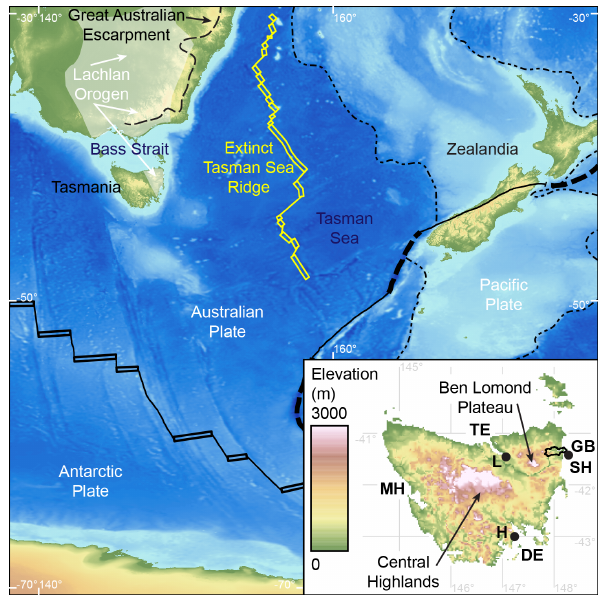
Figure 1. Generalized tectonic map of the eastern Southern Ocean and southwest Pacific Ocean, surrounding Tasmania, including large-scale geologic structures in southeast Australia and Tasmania: double-black lines are active mid-ocean ridges; bold dashed black line are convergent plate boundaries; thin solid black lines are trans- form boundaries. Inset shows detailed topography of Tasmania. The main George River basin is shown outlined in black. Major estuaries of other Tasmanian river systems are indicated for reference: Der- went Estuary (DE), Macquarie Harbour (MH), Tamar Estuary (TE), Georges Bay (GB). Cities are shown with black dots for reference: Hobart (H), Launceston (L), St. Helens